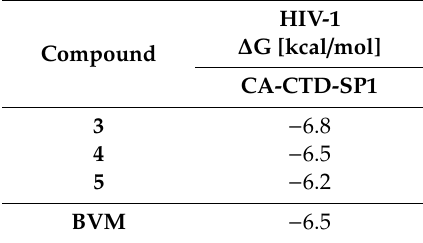
Table 2. Scoring functions of tested compounds (HIV-1 protein).